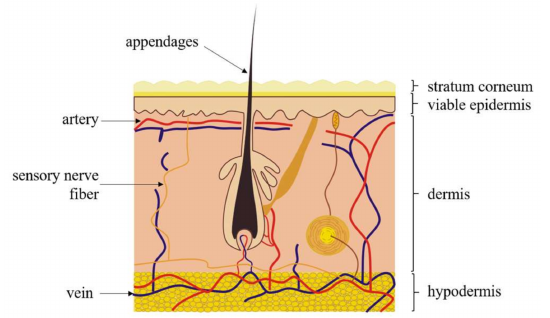
Figure 1. Sketch of the human skin layers. Moving from the outside to the inside: the stratum corneum (the outmost layer), the viable epidermis and the dermis